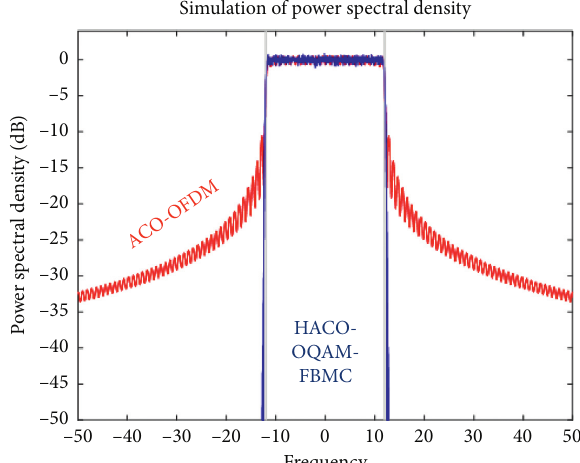
Figure 12: Simulation of the power spectral density (PSD) of ACO- OFDM and